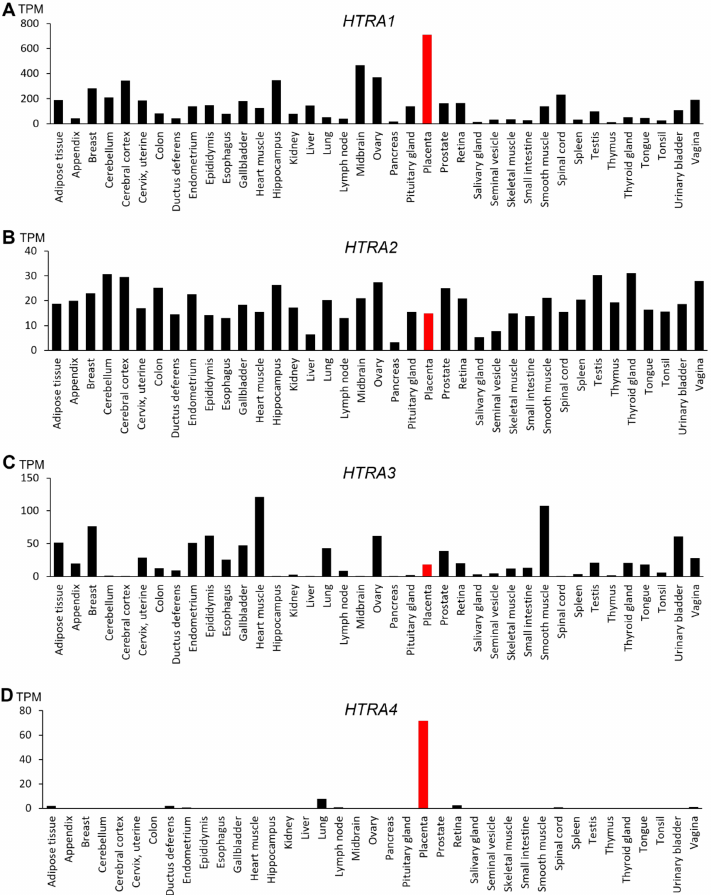
Figure 2. Gene expression profile of the four human HtrAs in 39 human tissues. Data obtained from National Centre for Biotechnology Information FANTOM5 dataset and expressed in transcripts per kilobase million (TPM). The placenta is highlighted in red. ( A ) HTRA1 ; ( B ) HTRA2 ; ( C ) HTRA3 ; ( D ) HTRA4